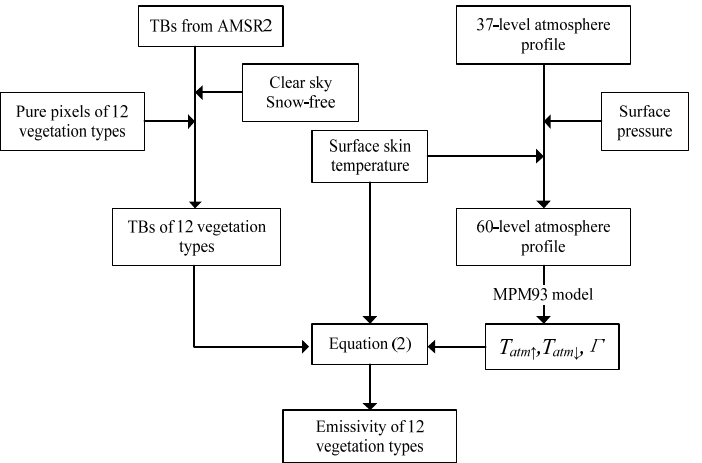
Figure 2. Flow chart of instantaneous MLSE retrieval for 12 vegetation types.